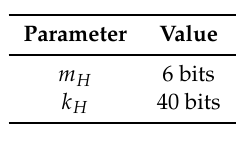
Table 1. Parameters of the studied Hamming code.